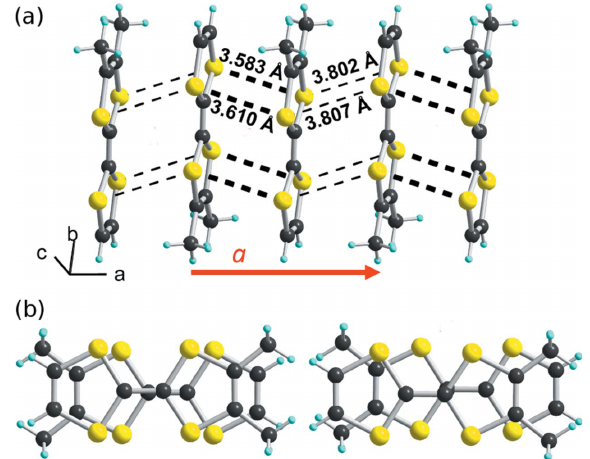
Figure 4 ( a ) A side view of one chain in ( o -Me 2 TTF) 2 NO 3 (stacking axis a ) with intermolecular S (cid:4)(cid:4)(cid:4) S contacts shown as black dotted lines. ( b ) The two different overlap patterns within one chain: (left) eclipsed and (right) bond-over-ring.